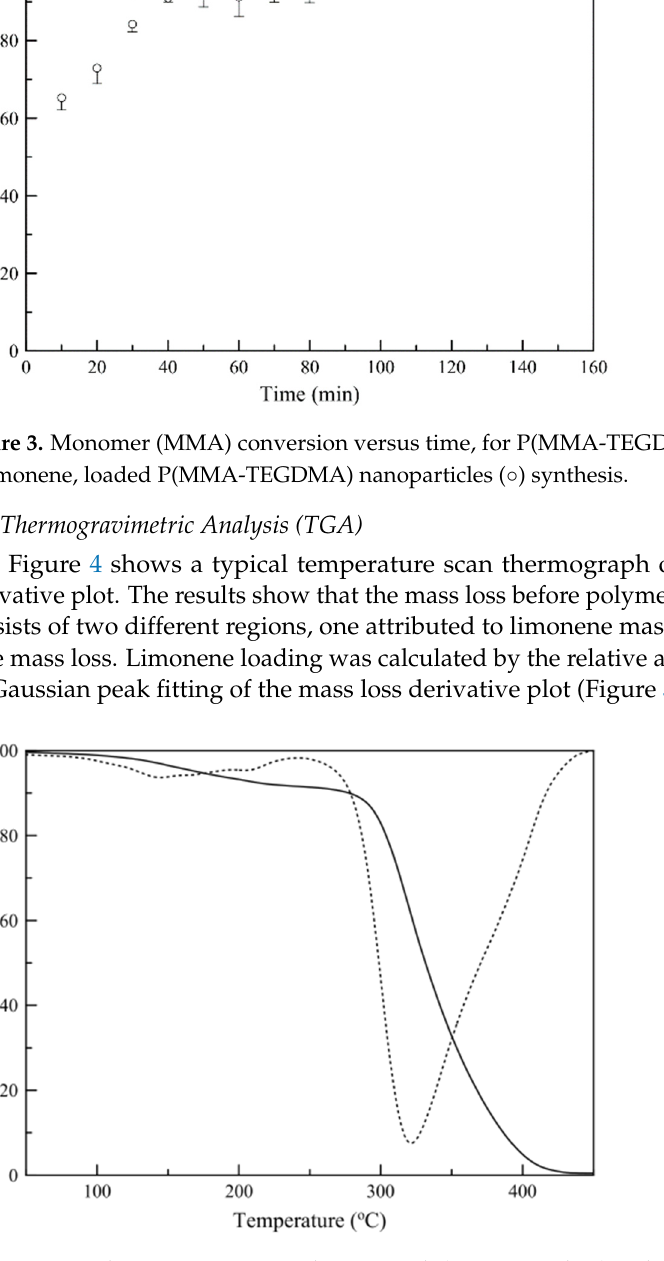
Figure 4. Sample temperature scan thermograph (continuous line) and derivative plot (dotted line).